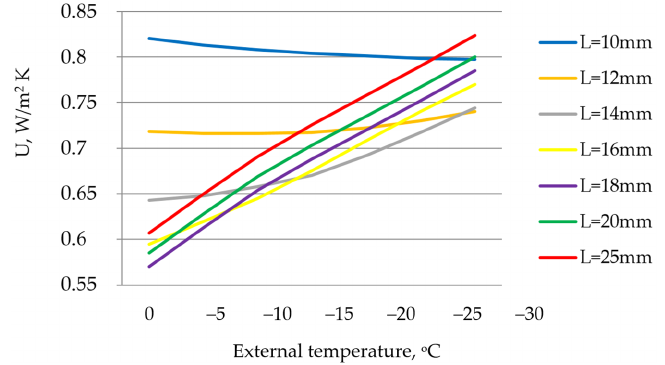
Figure 4. Dependence of the gap width and the outdoor temperature on the U − value of a double-pane window ( ε = 0.04) (summarized data from cited papers).